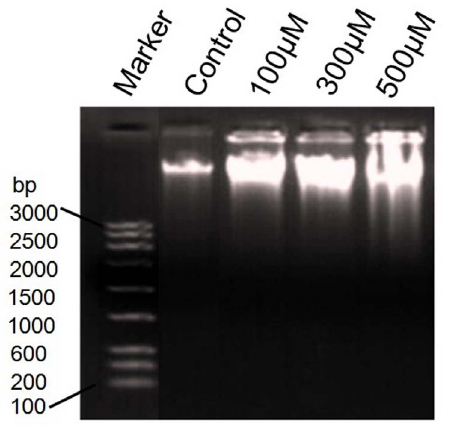
Figure 5. DNA fragmentation analysis. DNA fragmentation of A431cell treated with 100 m M, 200 m M and 300 m M of naringenin. 1 st well showing the 3 kb DNA marker. DNA laddering pattern showed that naringenin induces DNA fragmentation in a dose dependent manner.